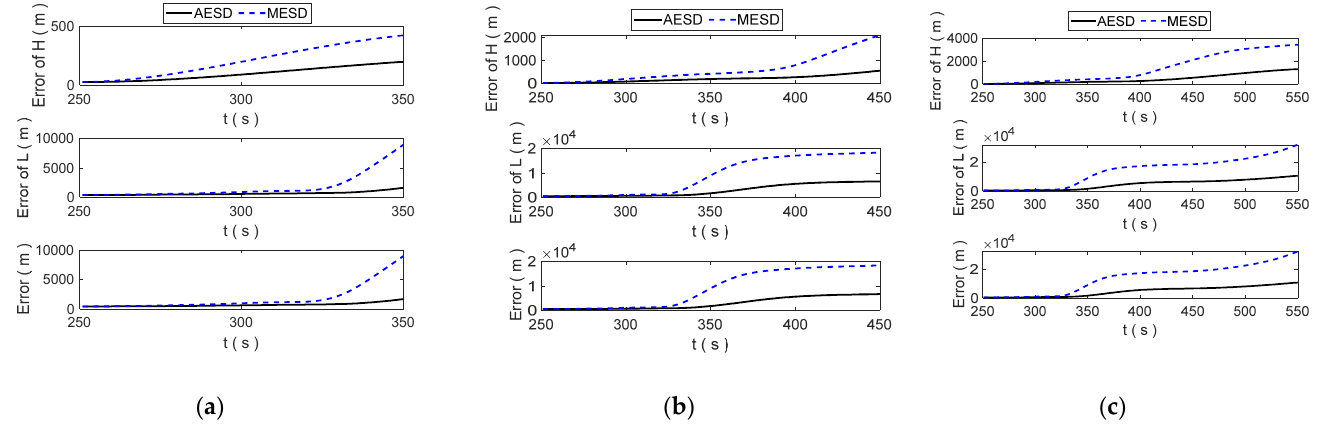
Figure 19. Variation of prediction error: ( a ) represents the longitudinal prediction error; ( b ) represents lateral prediction error; and ( c ) represents the whole prediction error.